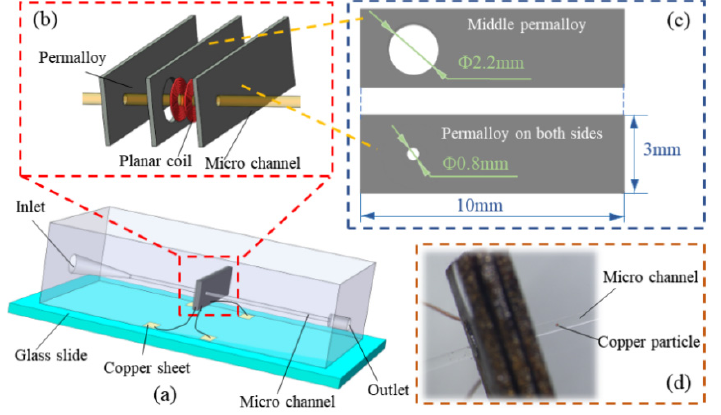
Figure 1. Schematic of the oil debris sensor: ( a ) three-dimensional structure of the sensors, ( b ) ex- ploded view of induction unit, ( c ) size of the permalloy, ( d ) physical map of sensing unit.